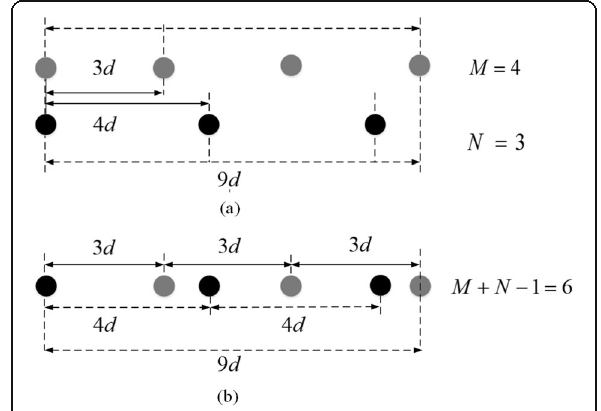
Fig. 2 Co-prime arrays. a Two uniform linear arrays. b Co-prime array formed by two uniform arrays. This picture gives an example of the co-prime arrays when M = 4 and N = 3 where the non- uniform array can be decomposed into two uniform linear arrays